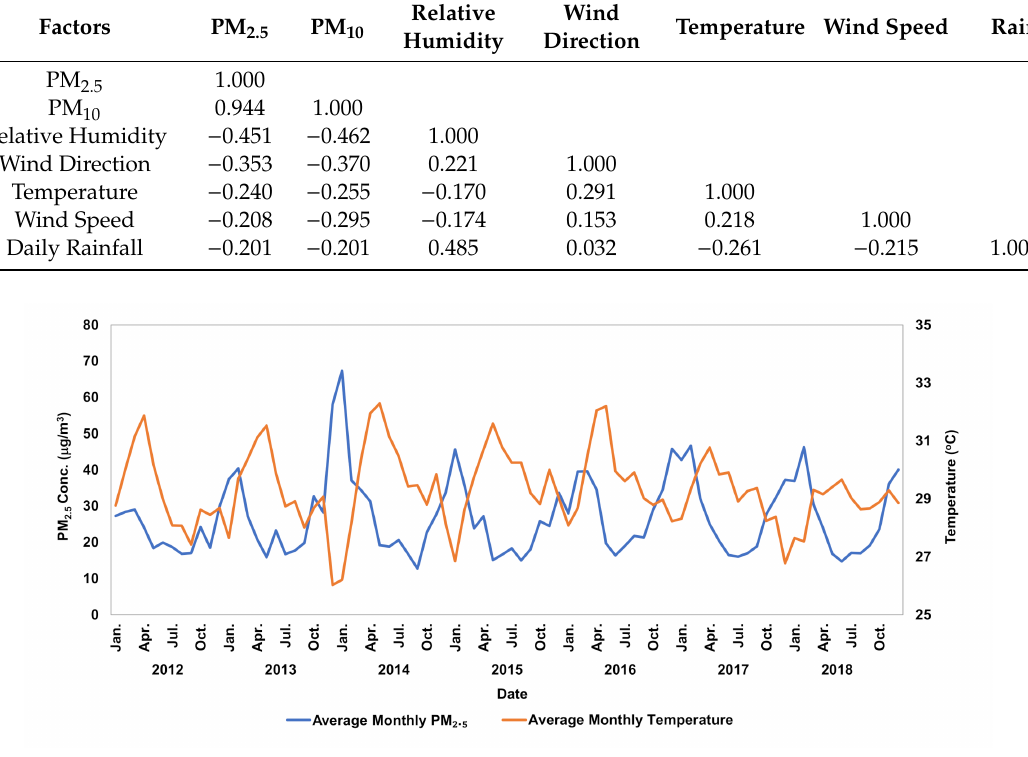
Figure 4. Monthly variation of PM 2.5 concentrations and temperatures during 2012–2018.